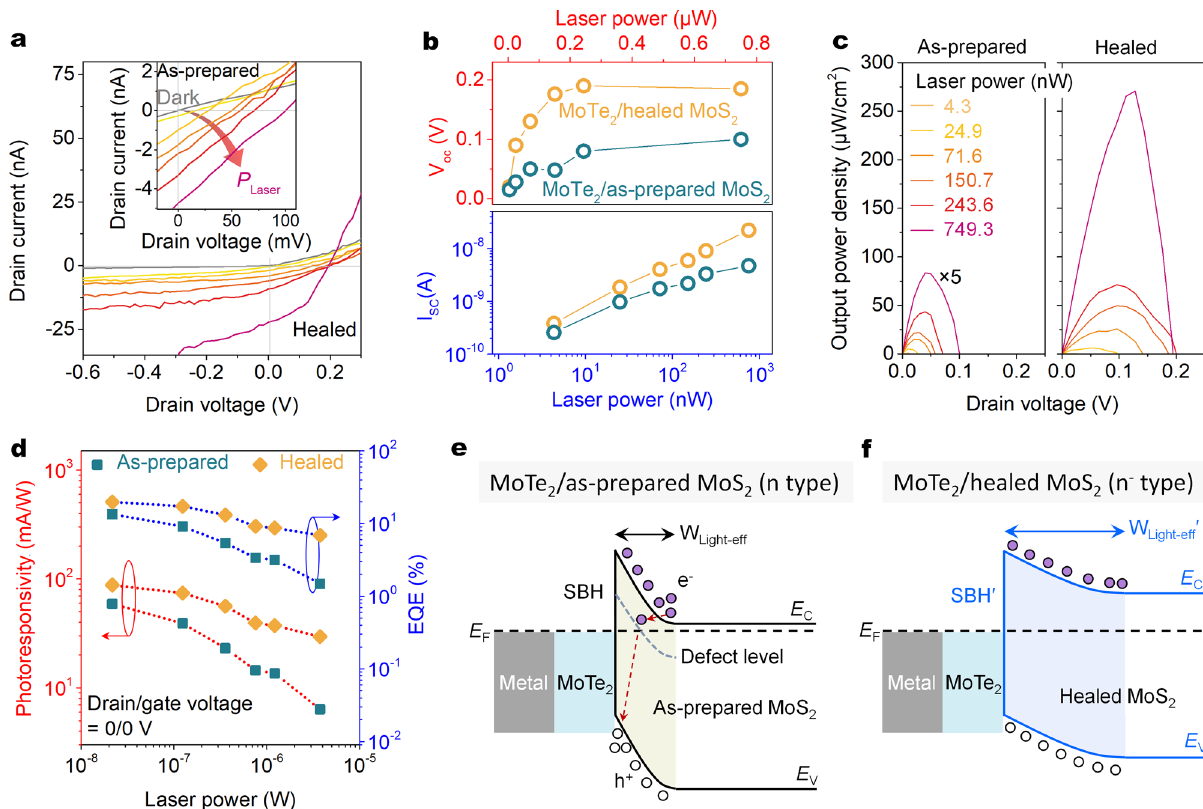
Fig. 5 Photoresponse optimization of the 1T ′ -MoTe 2 /MoS 2 Schottky junction photodiodes. a Output curves of the 1T ′ -MoTe 2 /healed MoS 2 and 1T ′ -MoTe 2 /as-prepared MoS 2 (inset) Schottky junctions in dark and under 532 nm light irradiation with various laser power densities ( P Laser ). The gate voltages before and after the SVSH are zero. b Short circuit current ( I SC ) and open-circuit voltage ( V OC ) as a function of P Laser extracted from ( a ). c Output electrical power of the as-prepared (left) and healed (right) devices as a function of drain-source voltage. d P Laser -dependent photoresponsivities (red) and EQE (blue) at zero bias. e , f Band structure diagrams of the 1T ′ -MoTe 2 /MoS 2 Schottky junctions before ( e ) and after ( f ) the SVSH under light irradiation. The purple and hollow circles represent electrons and holes, respectively. The red dashed arrow refers to the electron movement direction. The yellow and blue gradient areas refer to the depletion regions of the Schottky junctions. W Light-eff refers to the ef fi cient light absorption width of the Schottky